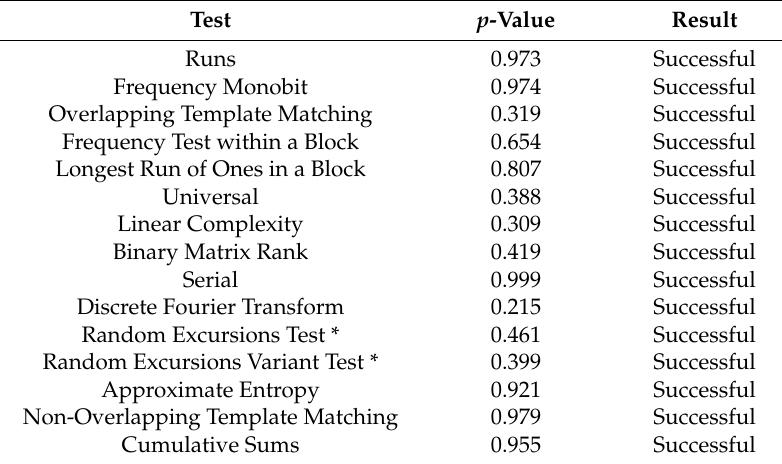
Table 1. NIST test results. First